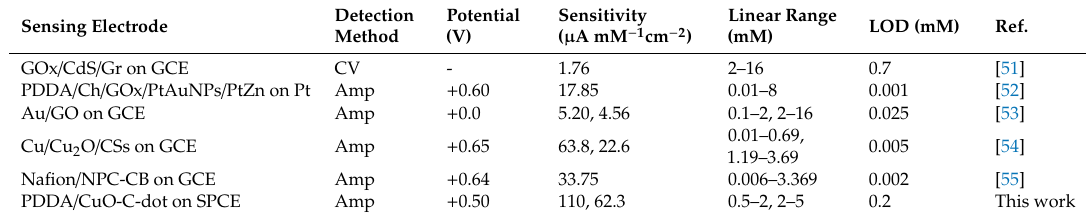
Figure 7. The chronoamperometric responses of PDDA/CuO-C-dots/SPCE for various glucose concentrations (0.5–5 mM) in 0.1 M NaOH at +0.50 V ( A ) and their calibration curve of current response vs. glucose concentration ( B ). Table 1. Comparison of the analytical performance of different glucose-sensing electrodes.